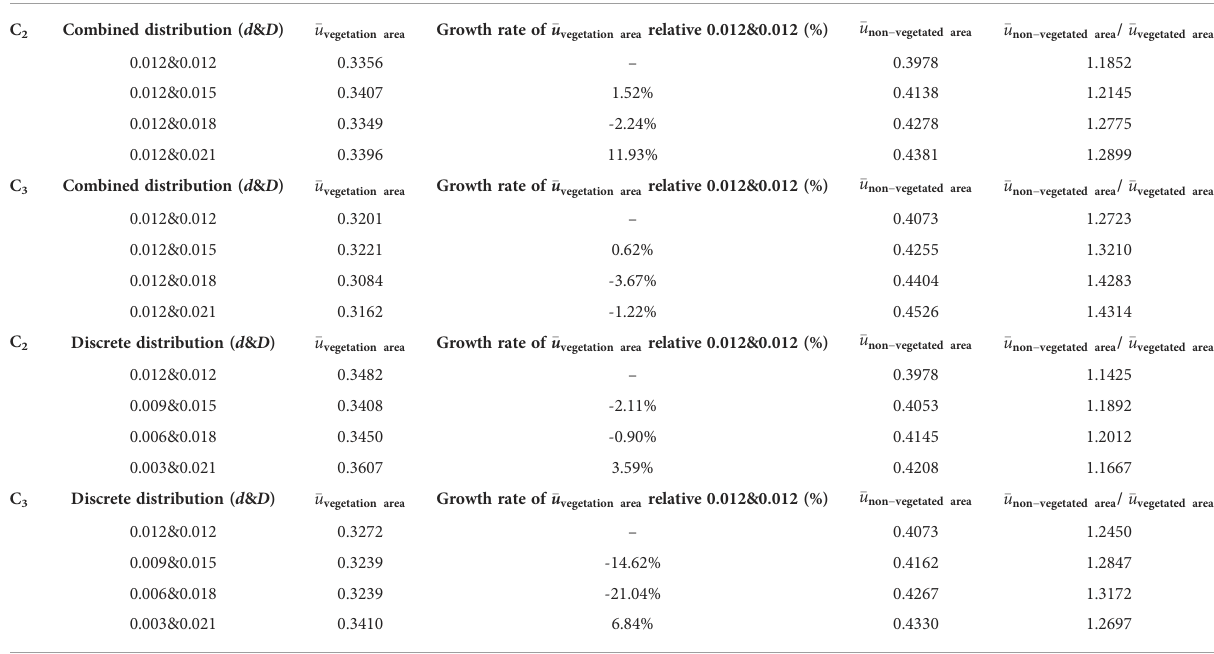
TABLE 2 The average streamwise velocity (cid:1) u value and its rate of change between C 1 and C 2 cross-sections under different distribution patterns when the submerged condition h is 0.10 m. Vegetation submerged state ( h